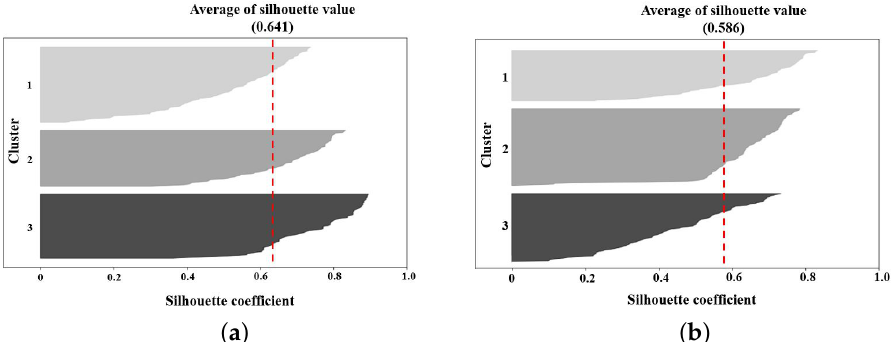
Figure 8. Results of silhouette coefficient by samples. ( a ) Sampling with severity ratio samples. ( b ) Simple random sampling without replacement.